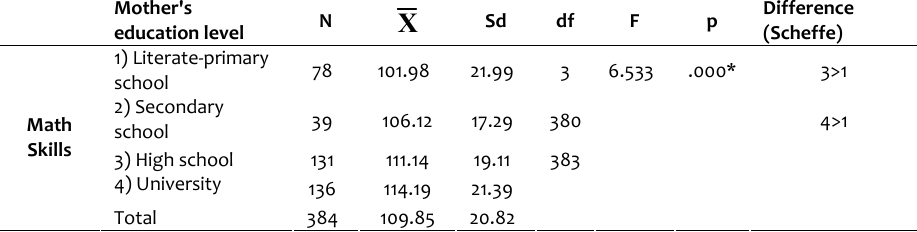
Table 10. Results of ANOVA on Math Skills of the 5-Year-Old Preschoolers According to Mother's Education